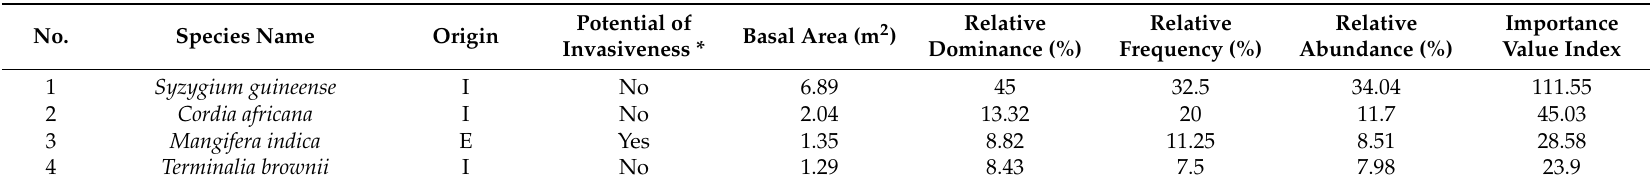
Table A2. Parkland woody and herbaceous perennial species ordered according to the frequency of occurrence in Assosa district, western Ethiopia.